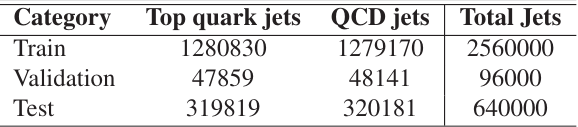
W-boson daughters, and W-boson daughters to be within an angular separation of ∆ R = ∆ η 2 + ∆ φ 2 < 0 . 8 from the reconstructed AK8 jet axis, where φ is the azimuthal angle of (cid:31)